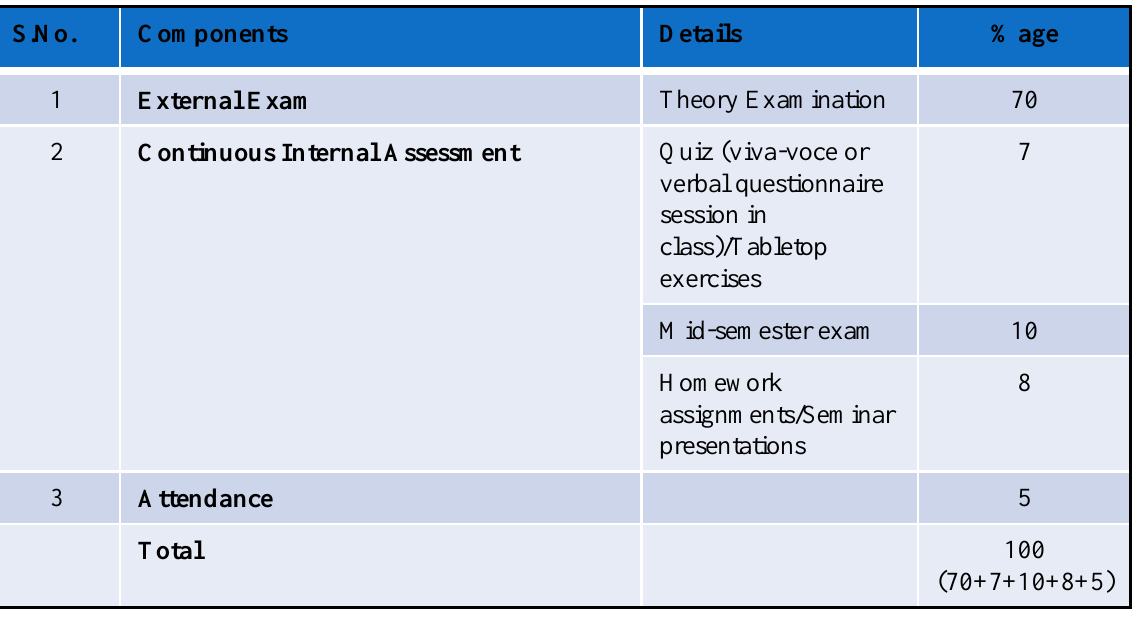
Table 3: Evaluation Process for Both Courses in Nuclear